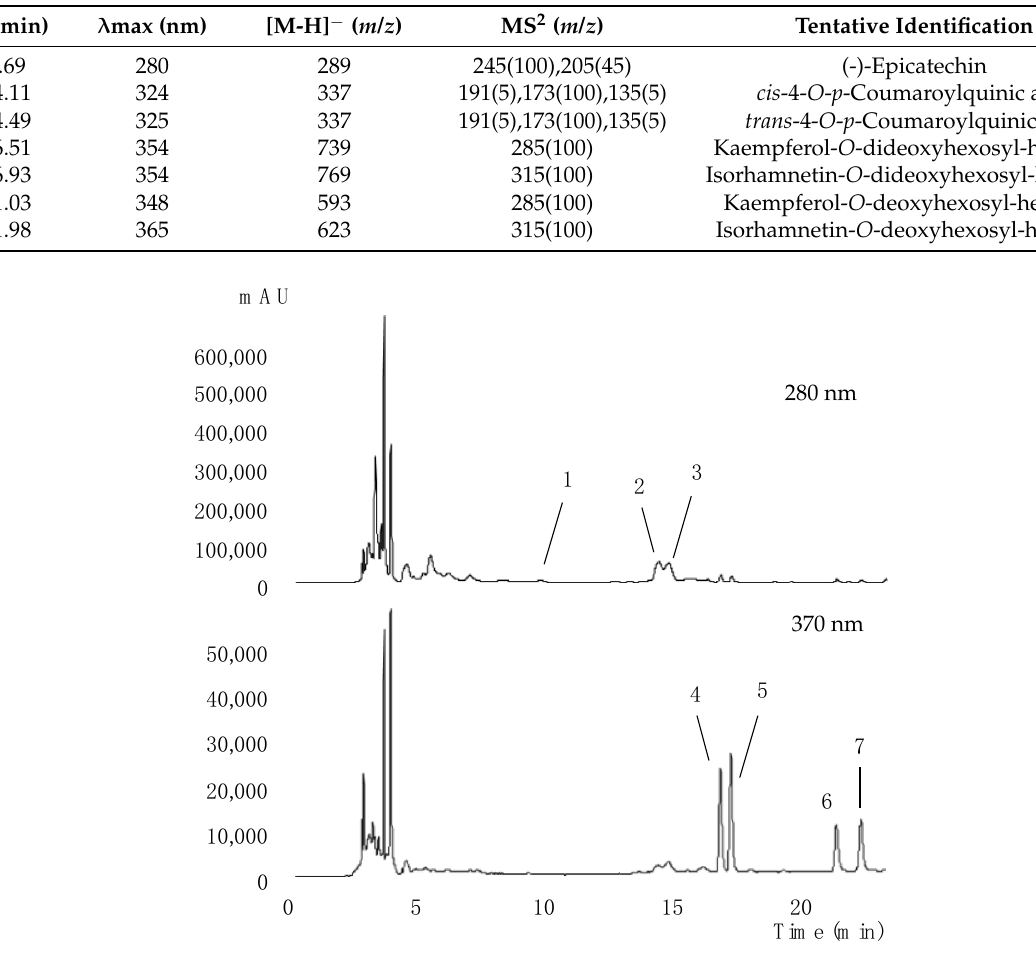
Table 11. Characterization of the phenolic compounds detected under the optimal conditions for each extract by HPLC-DAD-ESI/MS.